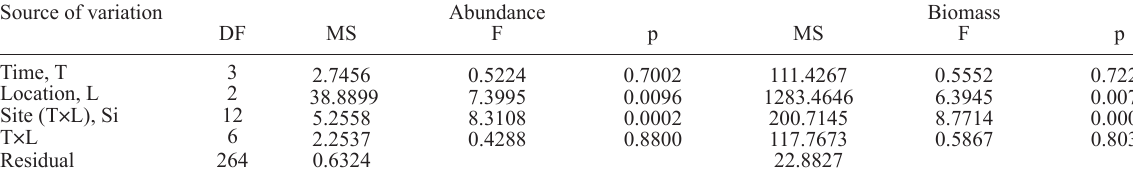
Table 2. – Results of the analysis of variance (ANOVA) testing the effects of ‘Time’ (a fixed factor), ‘Location’ (a random factor, orthogonal to the previous factor), and ‘Site’ (a random factor nested within ‘Time’ and ‘Location’) on the abundance and biomass of the pearly razorfish, Xyrichtys novacula , recorded through UVCs.